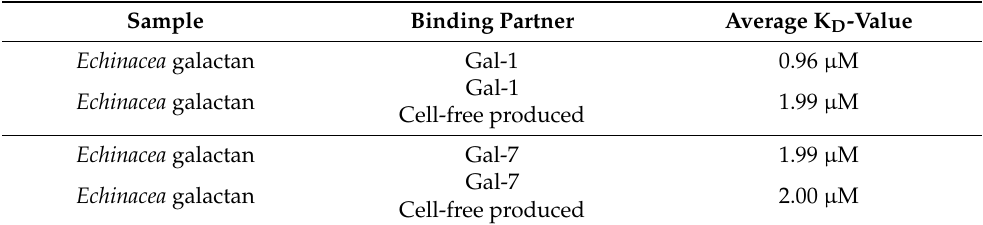
Table 2. Binding parameters of Gal-1 and Gal-7 with Echinacea galactan determined by BLI. Average K D -values were calculated from three independent experimental runs (Gal-1 and Gal-7) or the four concentrations of one experimental run (cell-free expressed Gal-1 and